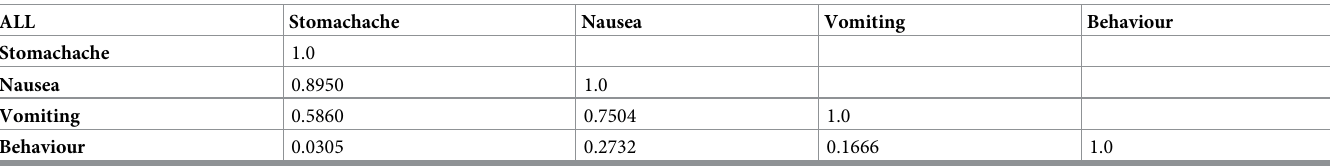
Table 6. Inter-domain correlations of the MISS–the acute lymphoblastic leukaemia group.